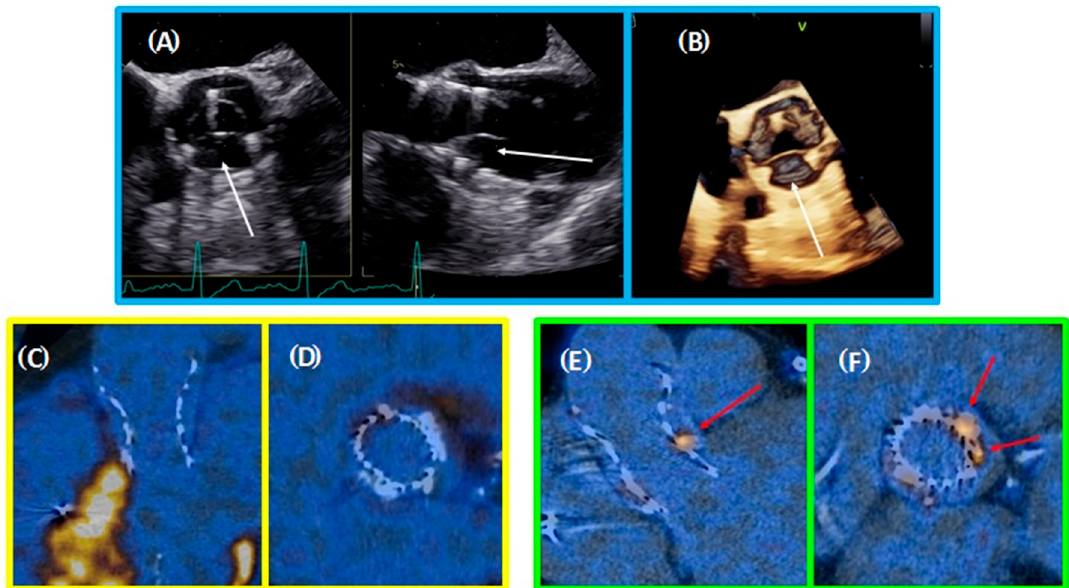
Figure 2. Blue frame: Transesophageal echocardiography ( A ) multi-D reconstruction: Acurate Neo valve with thrombotic leaflet (white arrows); ( B ) three dimensional reconstruction: Acurate Neo Valve with marked thrombotic leaflet (white arrow); Yellow frame: [ 18 F]F-fluorodeoxyglucose positron emission tomography/computed tomography — no visible uptake at the level of the leaflets; ( C ) TAVI valve long axis, ( D ) TAVI valve short axis; Green frame: [ 18 F]F-sodium fluoride positron emission tomography/computed tomography- red arrows: visible local uptakes out of the valve (aortic annulus calcifications); ( E ) TAVI valve long axis; ( F ) TAVI valve short axis.